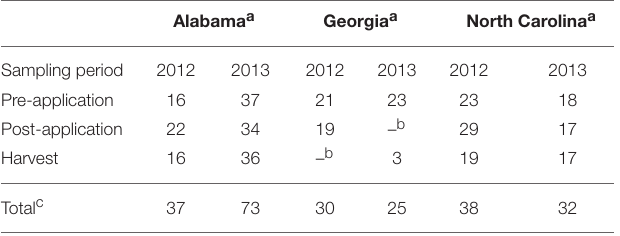
TABLE 4 | Number of unique multilocus haplotypes (MLHs) inferred from populations of Aspergillus flavus in soil from maize fields in southeastern United States treated with Afla-Guard and AF36 biocontrol strains in 2012 and 2013. Alabama a Georgia a